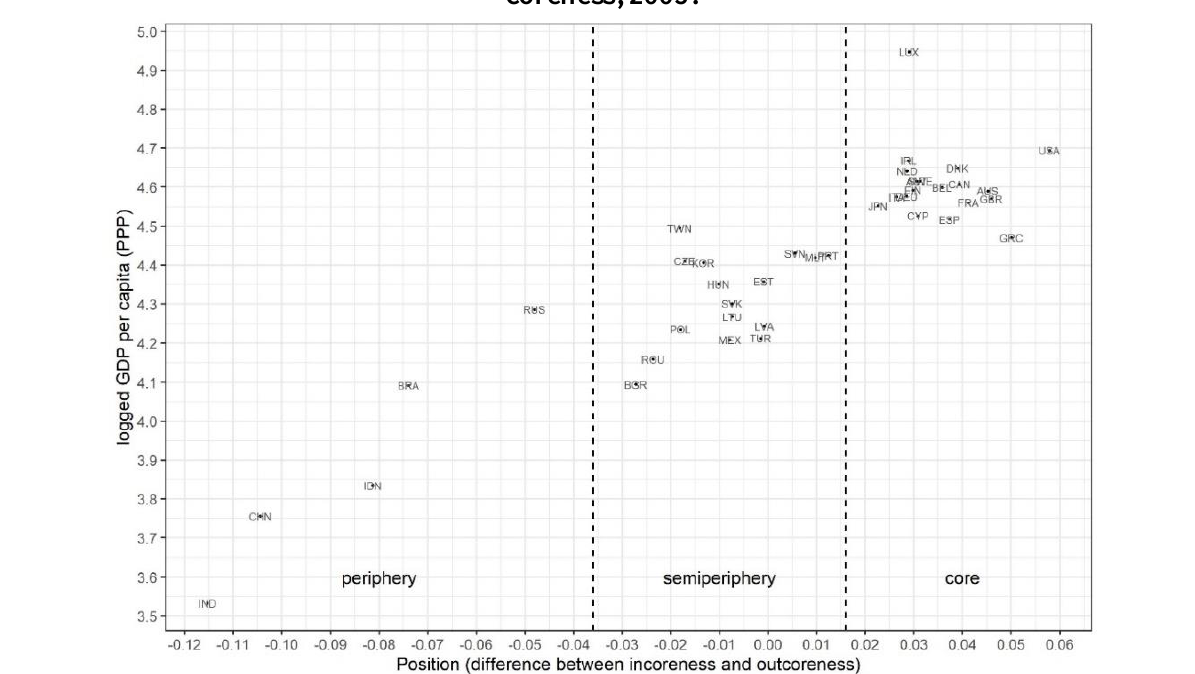
Figure 2. Log GDP per capita versus the difference between labor in-coreness and out- coreness, 2005.